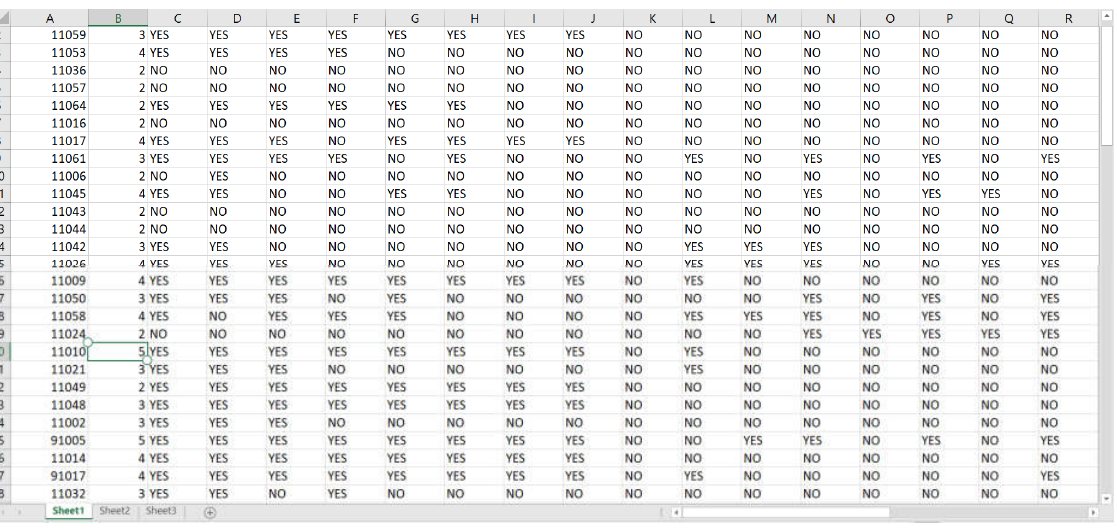
Figure 3. Final dataset.